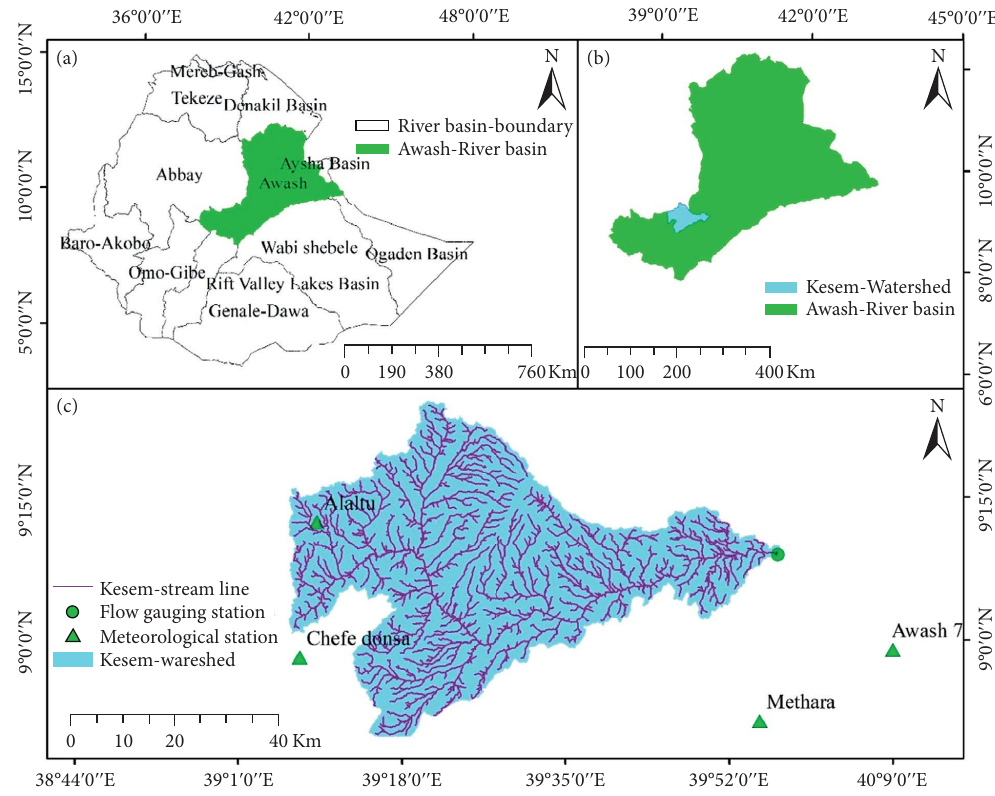
Figure 1: (a) Major river basins in Ethiopia, (b) Awash river basin, and (c) Kesem